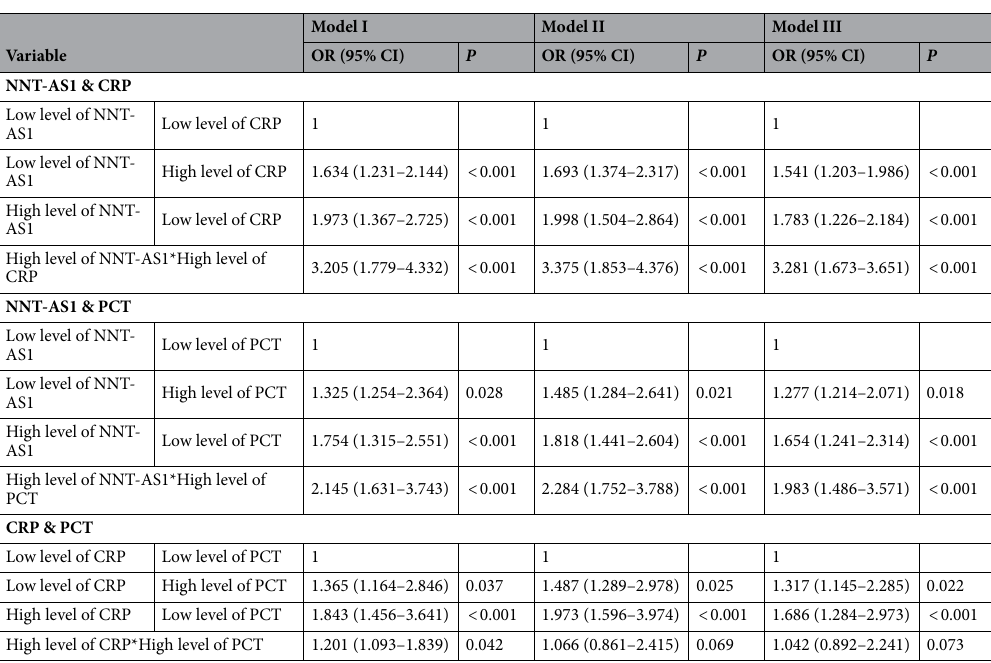
Table 5. Multiplicative interaction of related indicators. Model II: adjusting the fever days, hospital stay days, abnormal signs of lungs on the basis of Model I; Model III: adjusting IgA, IgG on the basis of Model II.